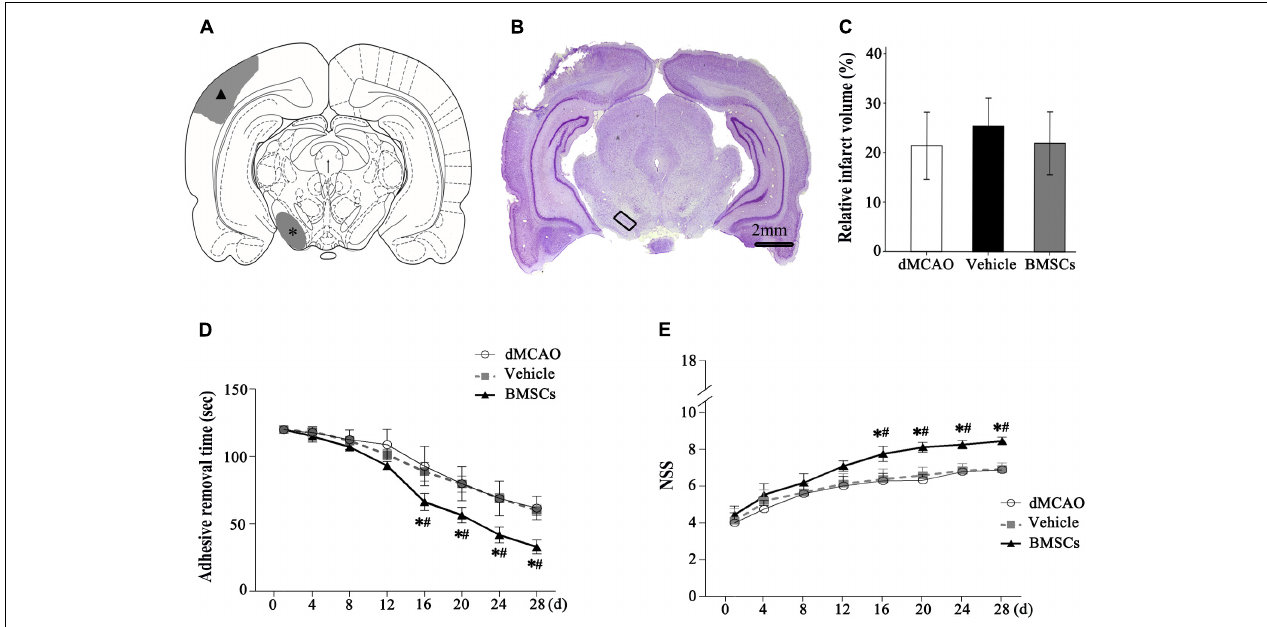
FIGURE 4 | Relative infarct volume and neurological functional evaluations with or without BMSCs transplantation after dMCAO in rats. (A) Schematic diagram of cortical infarction (marked with arrowhead) and ipsilateral SN (marked with asterisk). (B) Nissl-stained coronal brain sections of focal cortical infarction at 4 weeks after dMCAO. The infarcted tissue appeared white, while the intact tissue is colored. The ipsilateral SN was marked with quadrangle. (C) Quantitative analyses of relative infarct volume at 4 weeks after dMCAO. There was no significant difference in the relative infarct volume among dMCAO, vehicle and BMSCs groups [ F ( 2 , 18 ) = 0.478, p > 0.05]. (D) Adhesive removal test at 1–4 weeks after cortical infarction. Quantitative analyses showed that transplantation of BMSCs reduced the mean time to remove the adhesive from the forepaws after dMCAO [ F ( 2 , 19 ) 16 d = 16.87, p < 0.01; F ( 2 , 19 ) 20 d = 19.76, p < 0.01; F ( 2 , 19 ) 24 d = 30.14, p < 0.01; F ( 2 , 22 ) 28 d = 52.75, p < 0.01]. (E) NSS at 1–4 weeks after dMCAO. Quantitative analyses showed that transplantation of BMSCs raised NSS after dMCAO [ F ( 2 , 19 ) ∗ p < 0.05 vs. dMCAO groups, # p < 0.05 vs. 16 d = 22.08, p < 0.01; F ( 2 , 19 ) 20 d = 54.54, p < 0.01; F ( 2 , 19 ) 24 d = 60.91, p < 0.01; F ( 2 , 18 ) 28 d = 79.67, p < 0.01]. vehicle groups ( n = 7 in each group). dMCAO, distal middle cerebral artery occlusion; BMSCs, bone marrow stromal cells; NSS, neurological severity score; d,